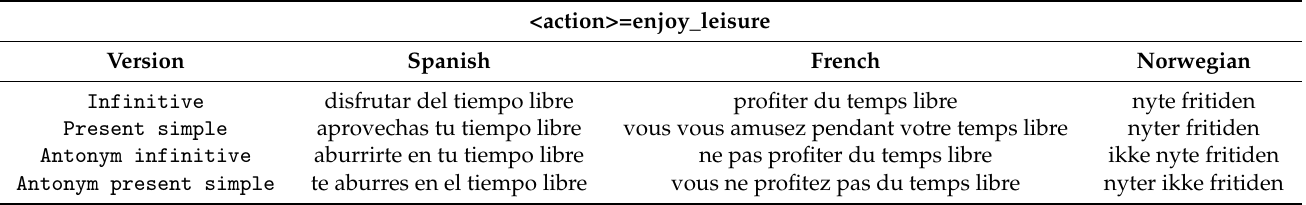
Table 3. Example of grammatical variation of the attribute value for the language-independent DA “enjoy_leisure”.